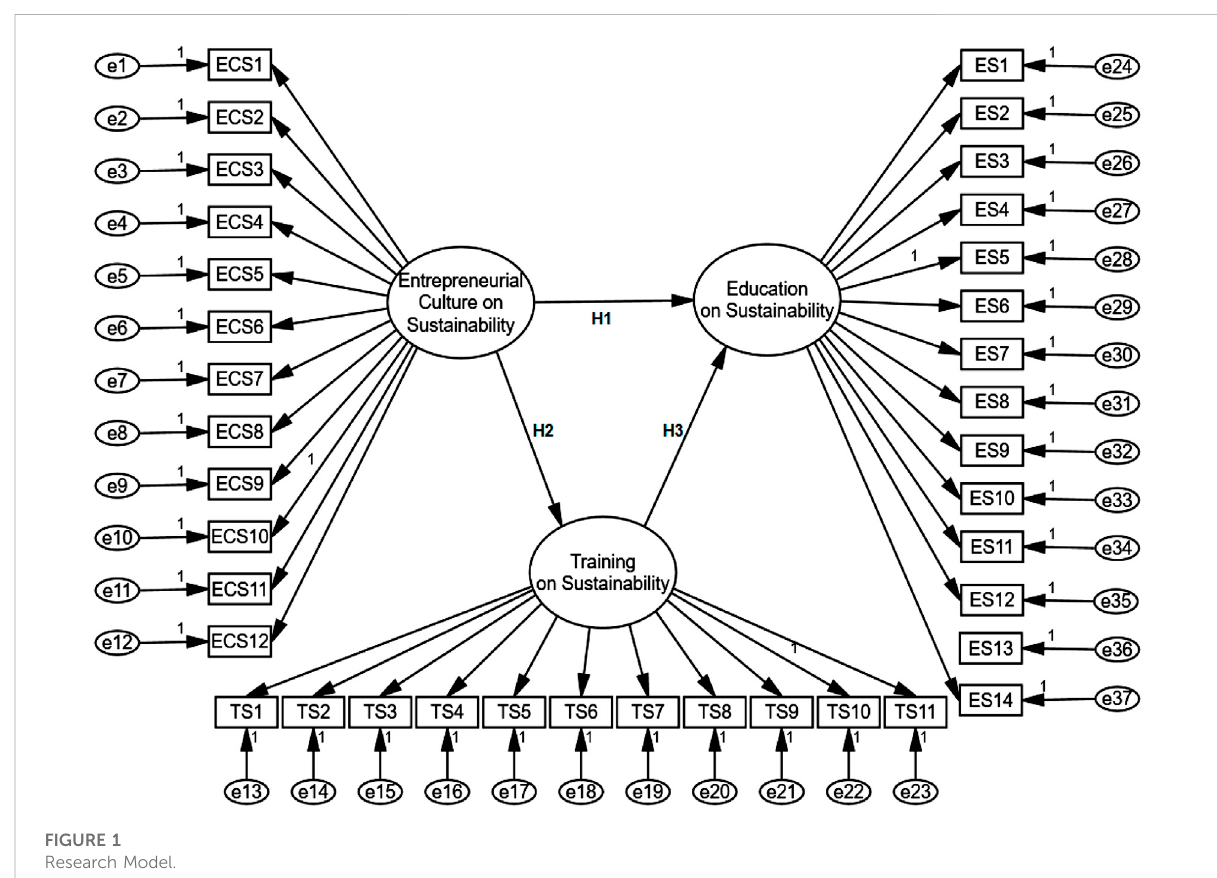
FIGURE 1 Research